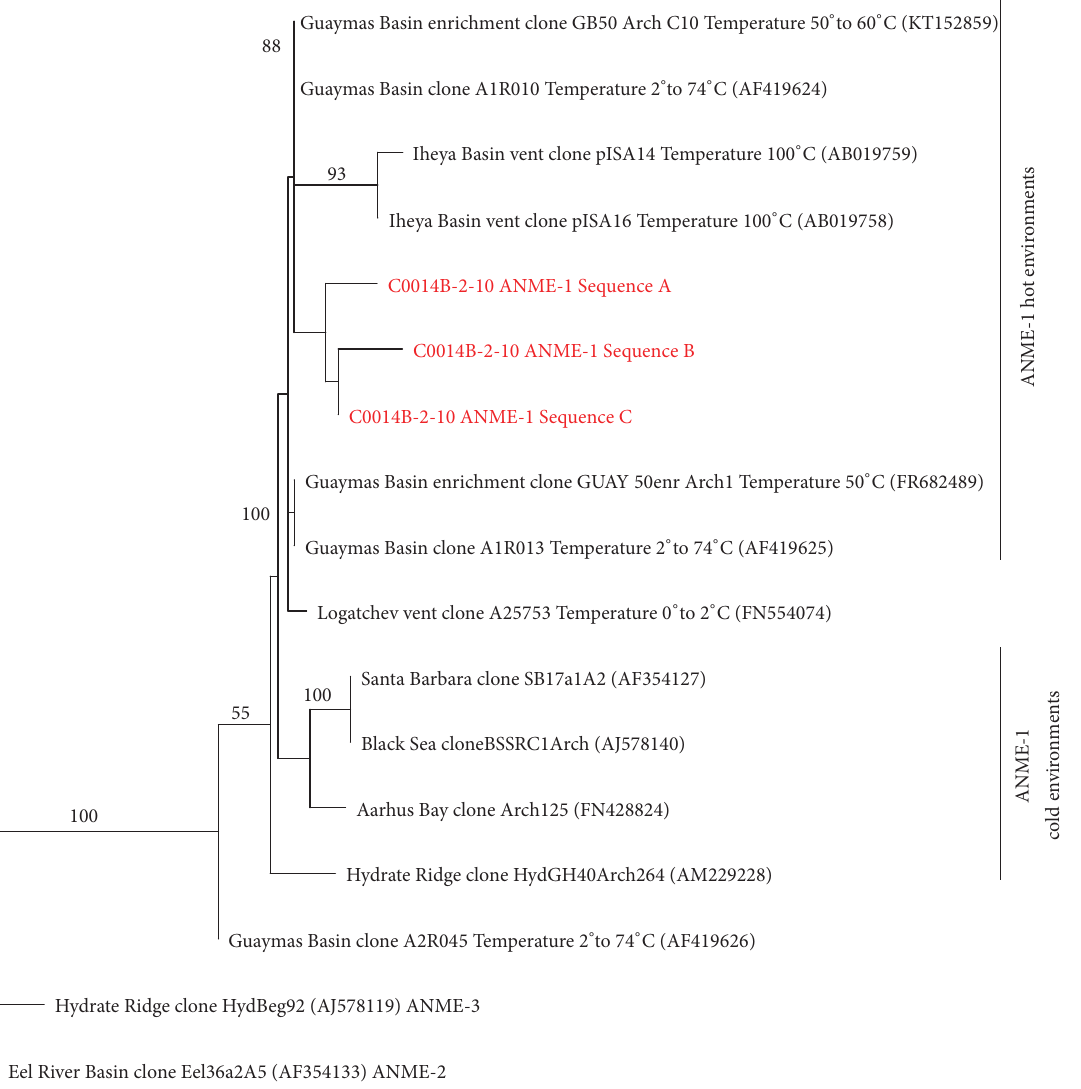
Figure 4: Maximum likelihood constraint tree in which full length 16S rRNA gene reference sequences (black) represent a base topology on which the amplicon sequences corresponding with ANME-1 from C0014B-2-10 are mapped (red). Bootstrap support is shown on full-length sequences from the initial full-length analysis. In parentheses are the NCBI accession